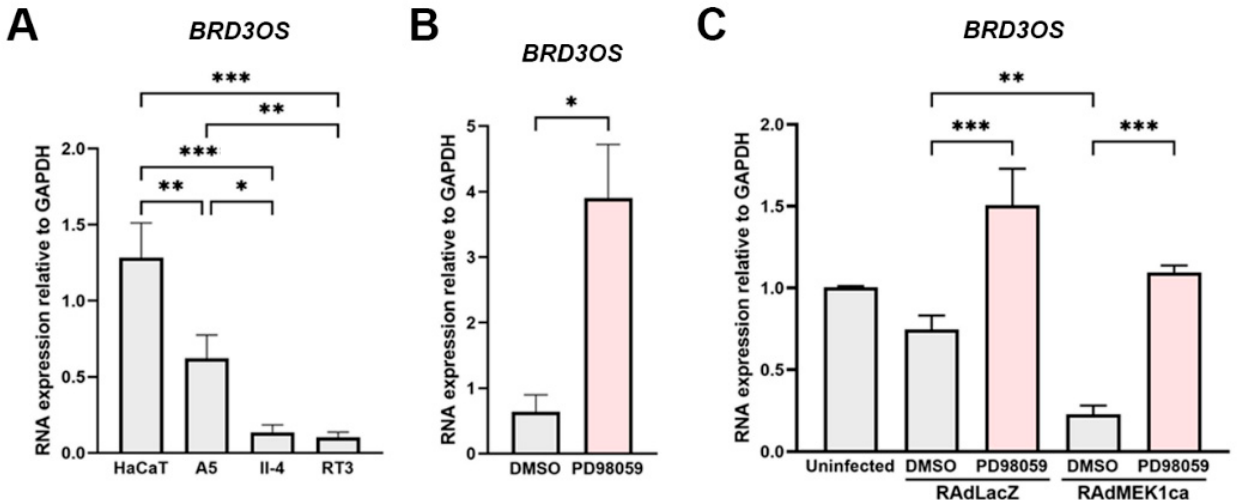
Figure 3. BRD3OS ( LINC00094 ) expression by cSCC cells is regulated by ERK1/2 pathway.